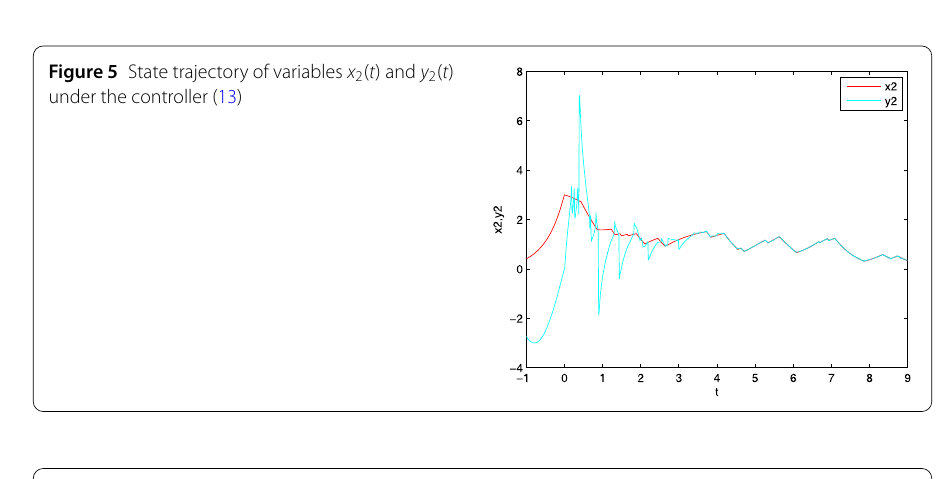
Figure 6 State trajectory of variables x 3 ( t ) and y 3 ( t ) under the controller (13)